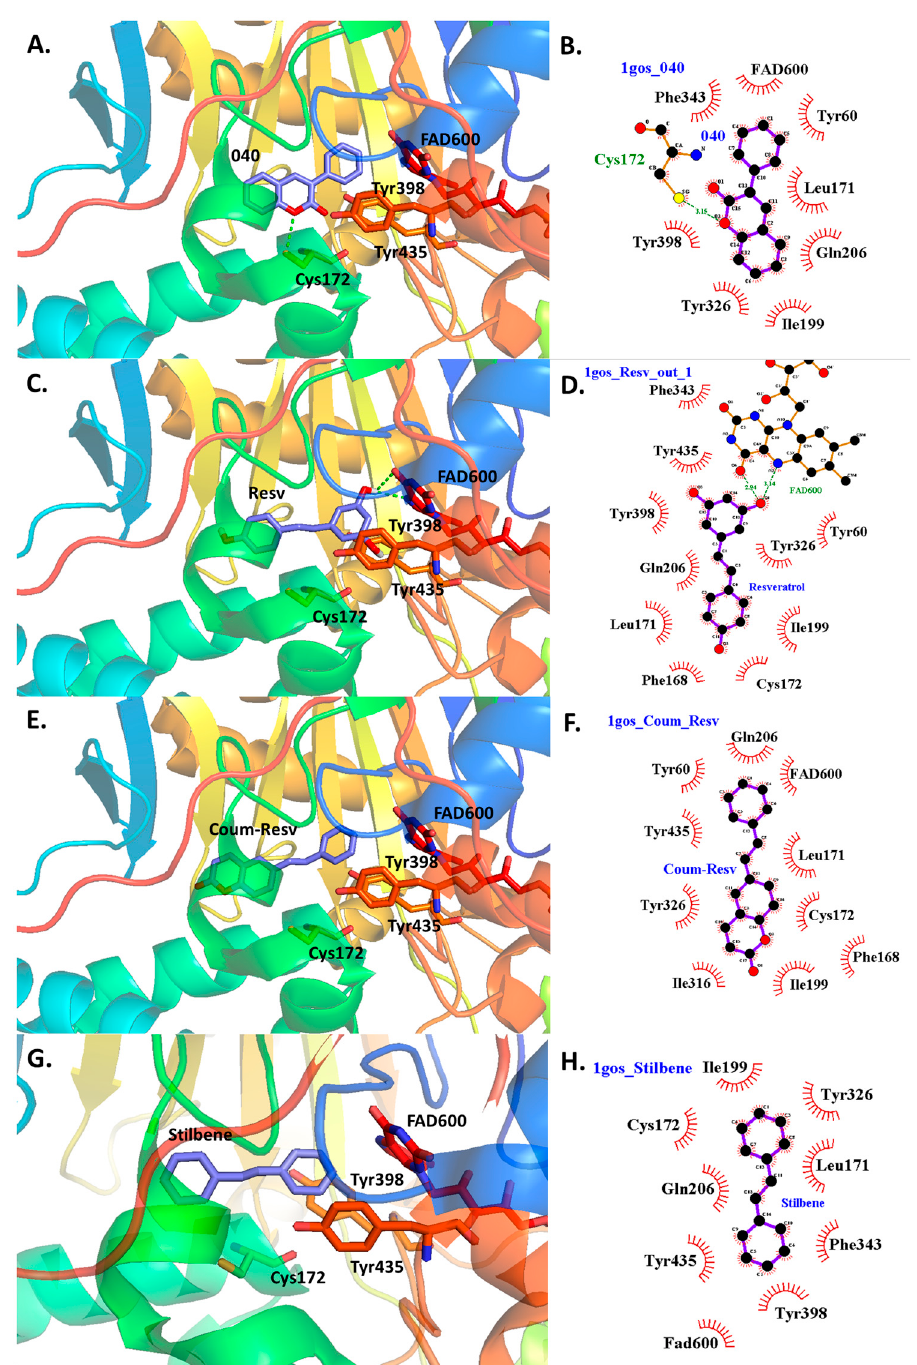
Figure 8. Molecular docking of 3-phenylcoumarin, trans -resveratrol, trans -6-styrylcoumarin and trans -stilbene on MAO-B binding pocket. ( A ) Best orientation of 3-phenylcoumarin on the MAO-B active site. ( B ) Details of polar and van der Waals interactions established by 3-phenylcoumarin with the residues of the MAO-B active site. ( C ) Best orientation of trans -resveratrol on the MAO-B active site. ( D ) Details of polar and van der Waals interactions established by trans -resveratrol with the residues of the MAO-B active site. ( E ) Best orientation of trans -6-styrylcoumarin on the MAO-B active site. ( F ) Details of polar and van der Waals interactions established by trans -6-styrylcoumarin with the residues of the MAO-B active site. ( G ) Best orientation of trans -stilbene on the MAO-B active site. ( H ) Details of polar and van der Waals interactions established by trans -stilbene with the residues of the MAO-B active site.